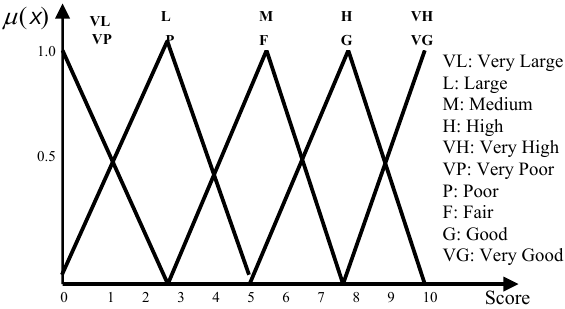
Fig. 3. Membership functions for linguistic